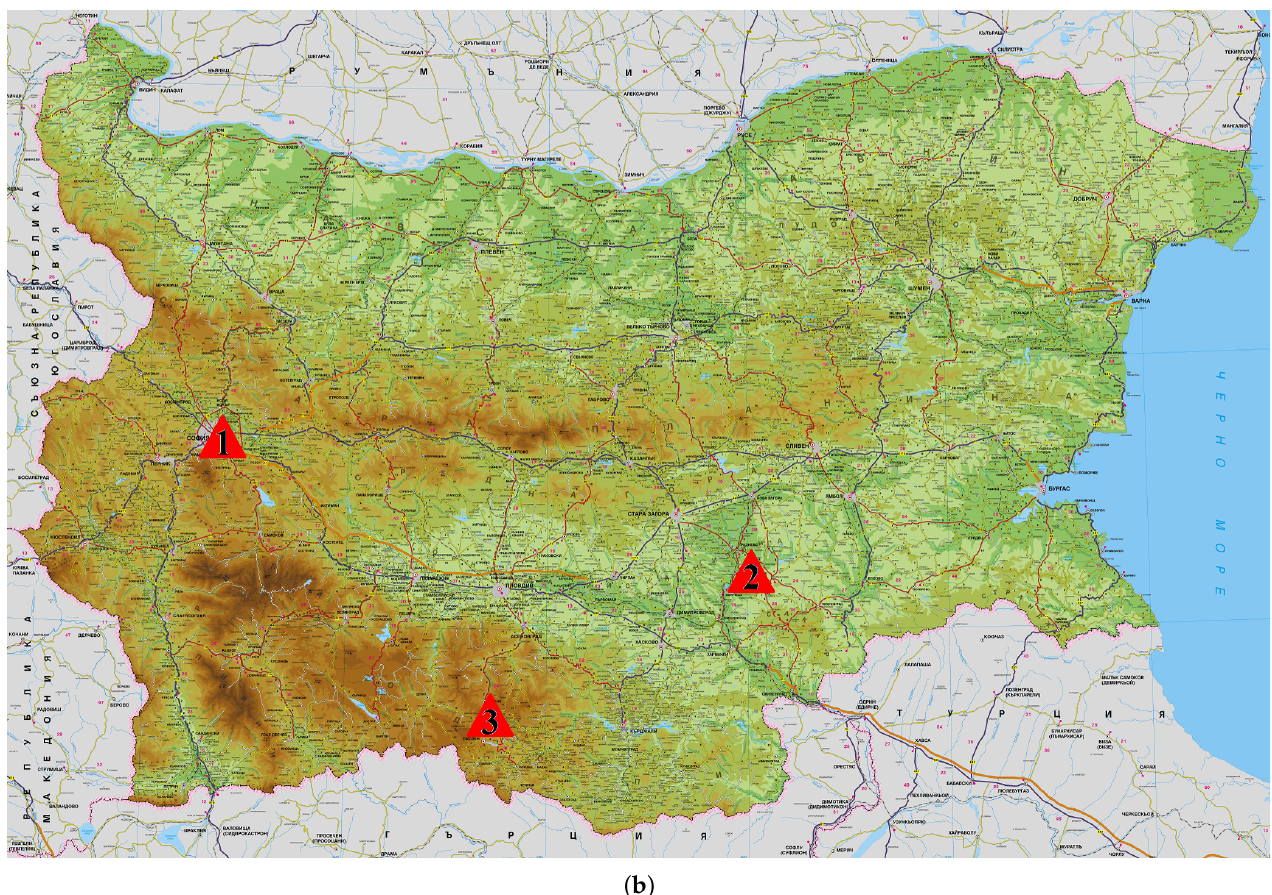
Figure 1. ( a ) The three nested integration domains with horizontal grid resolution 81 km (D1), 27 km (D2) and 9 km (D3), ( b ) Topography map of Bulgaria with the points Sofia (1), Maritsa TPPs (2) and Rozhen